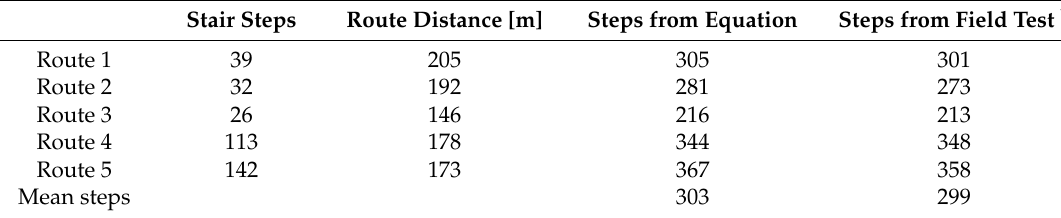
Table 1. Comparison of the estimated steps from the equation and the collected data.